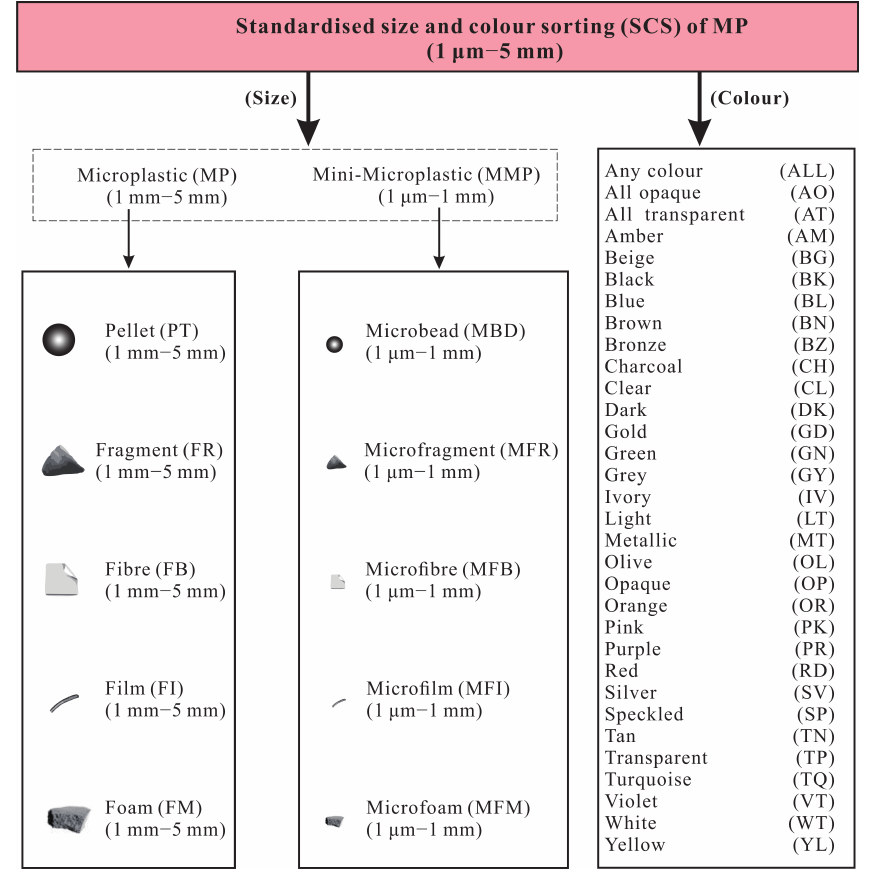
Figure 2. new fig 2. Figure 2. The standardized size and color sorting (SCS) system.